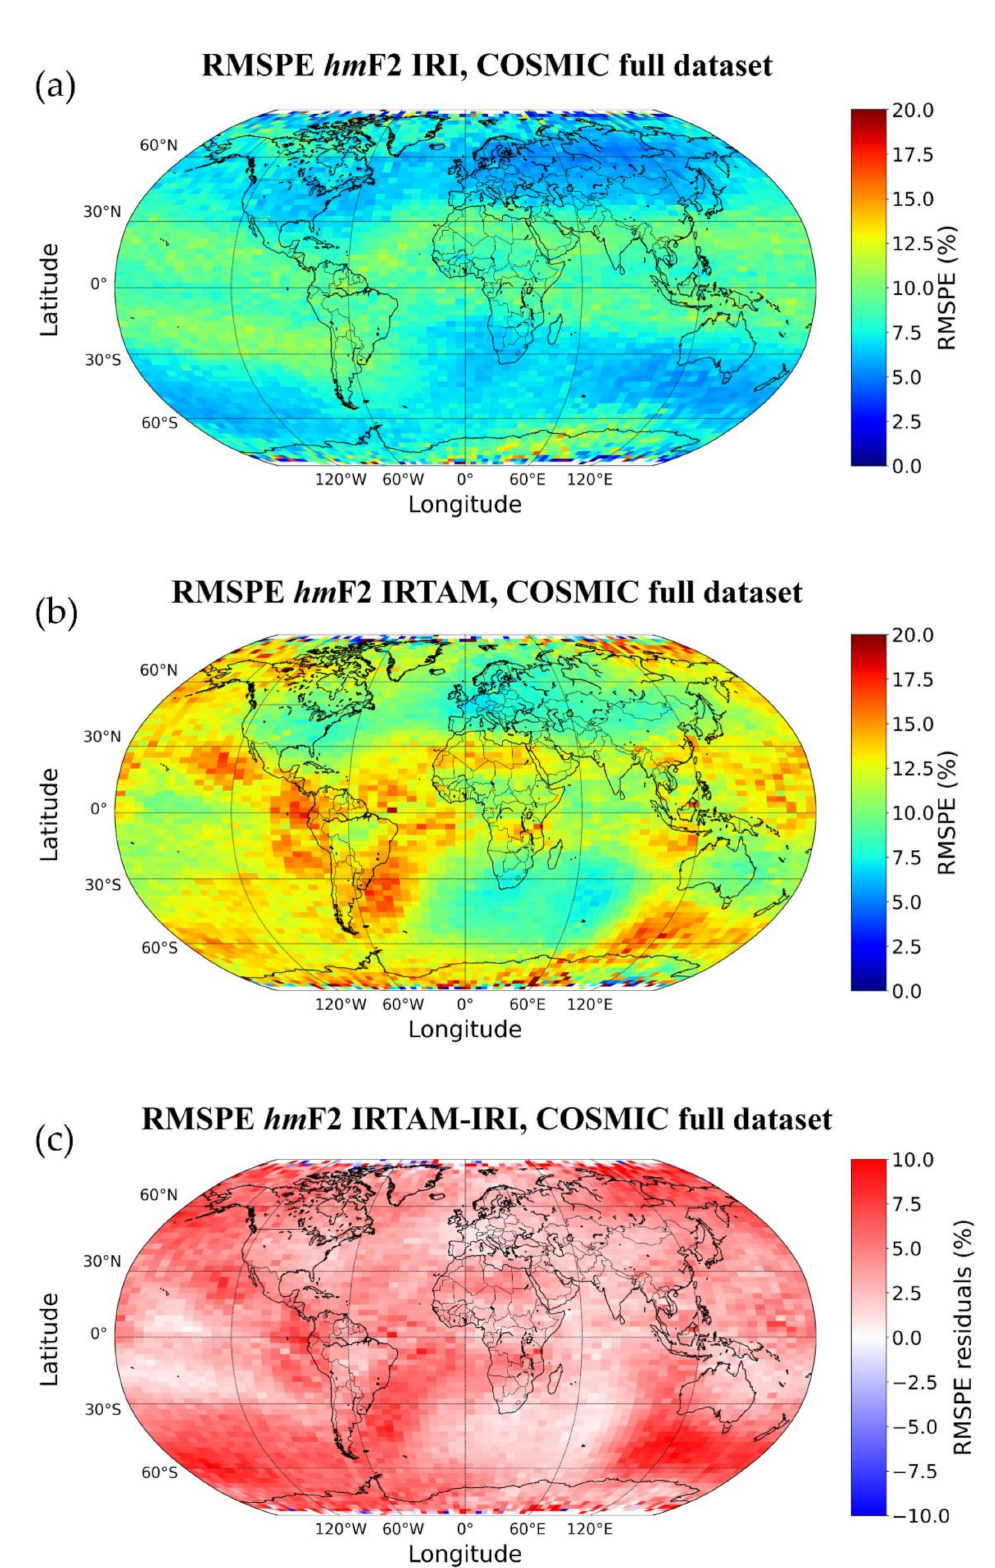
Figure 41. Maps of binned RMSPE values calculated between hm F2 values measured by COSMIC satellites and modeled by ( a ) IRI and ( b ) IRTAM, and ( c ) the corresponding map of differences. Data were binned as a function of the geographic latitude (2.5 ◦ -wide bins) and longitude (5 ◦ -wide